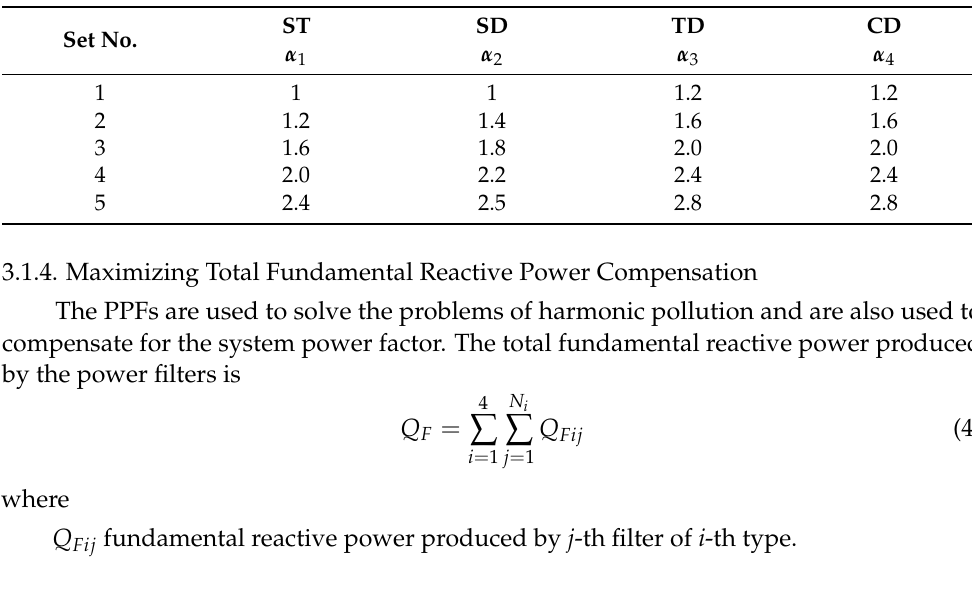
Table 2. Set coefficient α i